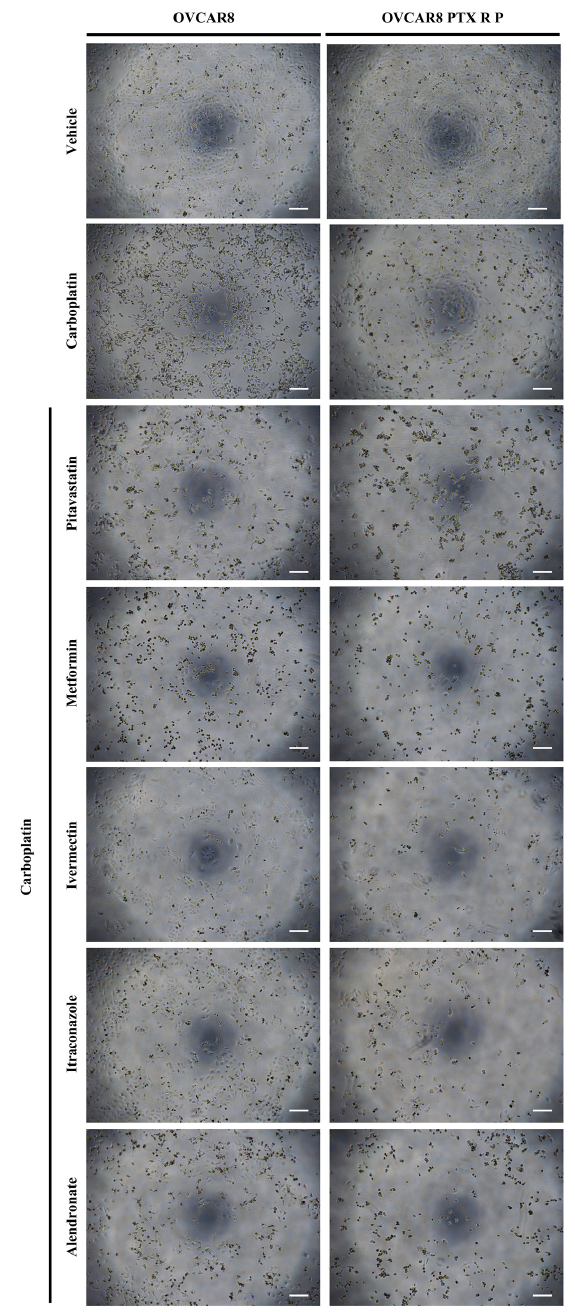
Figure 2. Repurposed drugs improved the cytotoxic effect of Carboplatin on chemoresistant high ‐ grade serous carcinoma cells. Representative microscopy images of OVCAR8 and OVCAR8 PTX R P cells after exposure to vehicle, Carboplatin, Carboplatin + Pitavastatin, Carboplatin + Metformin, Carboplatin + Ivermectin, Carboplatin + Itraconazole and Carboplatin + Alendronate at IC 50 values of each drug for 48 h. All assays were performed in triplicate in at least three independent experi ‐ ments. Scale bar, 200 μ m.